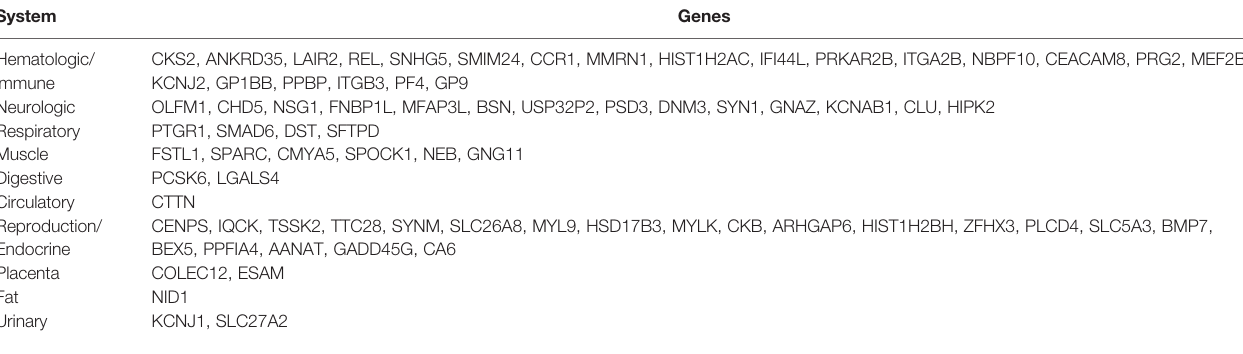
TABLE 3 | Tissue-speci fi c expressed genes identi fi ed by